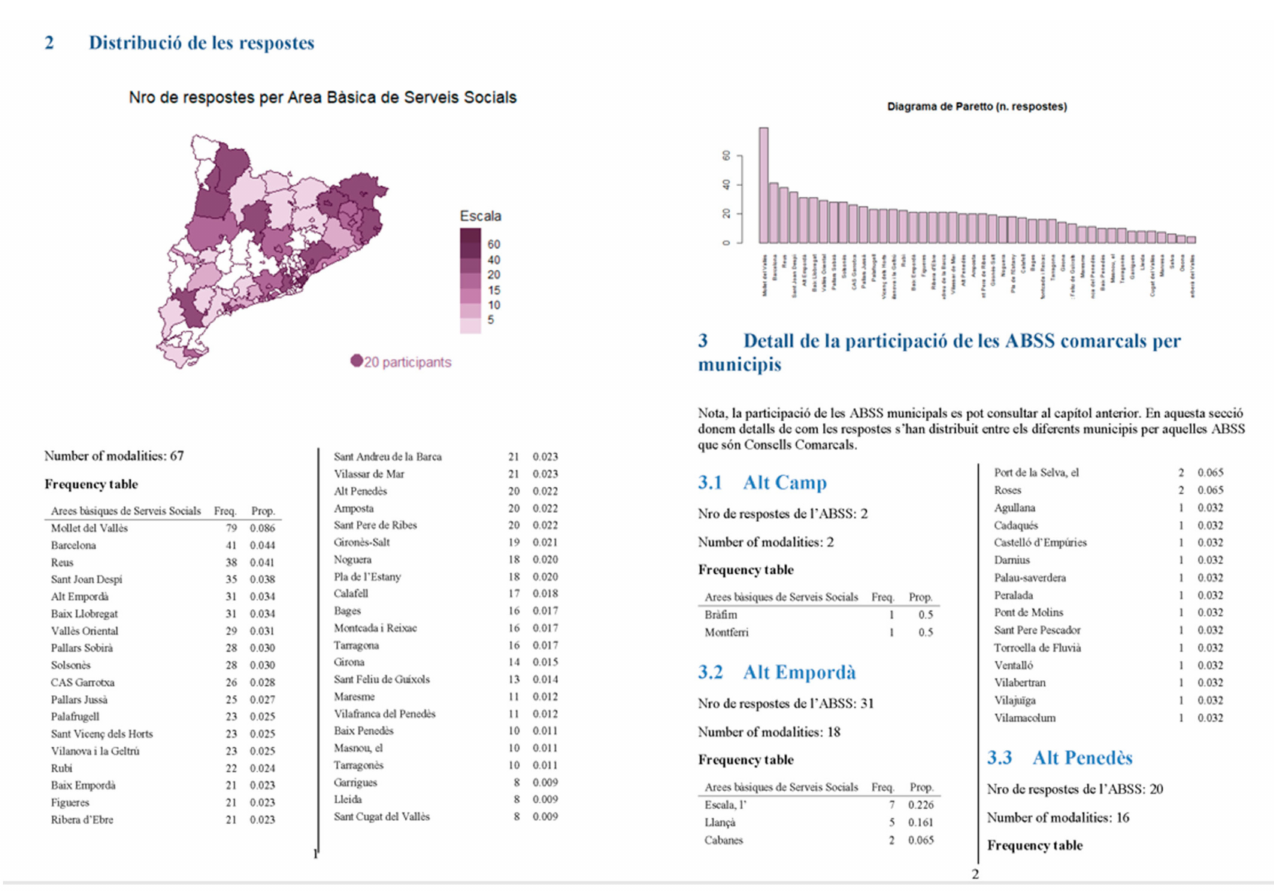
Figure 16. Sample pages of automatic